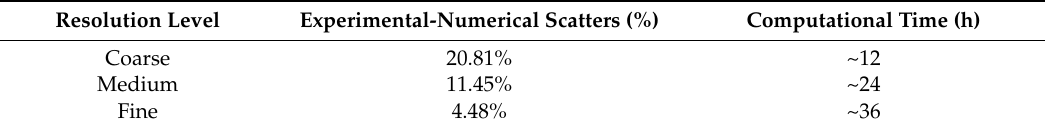
Table 5. Scatters and computational time for considered mesh resolution